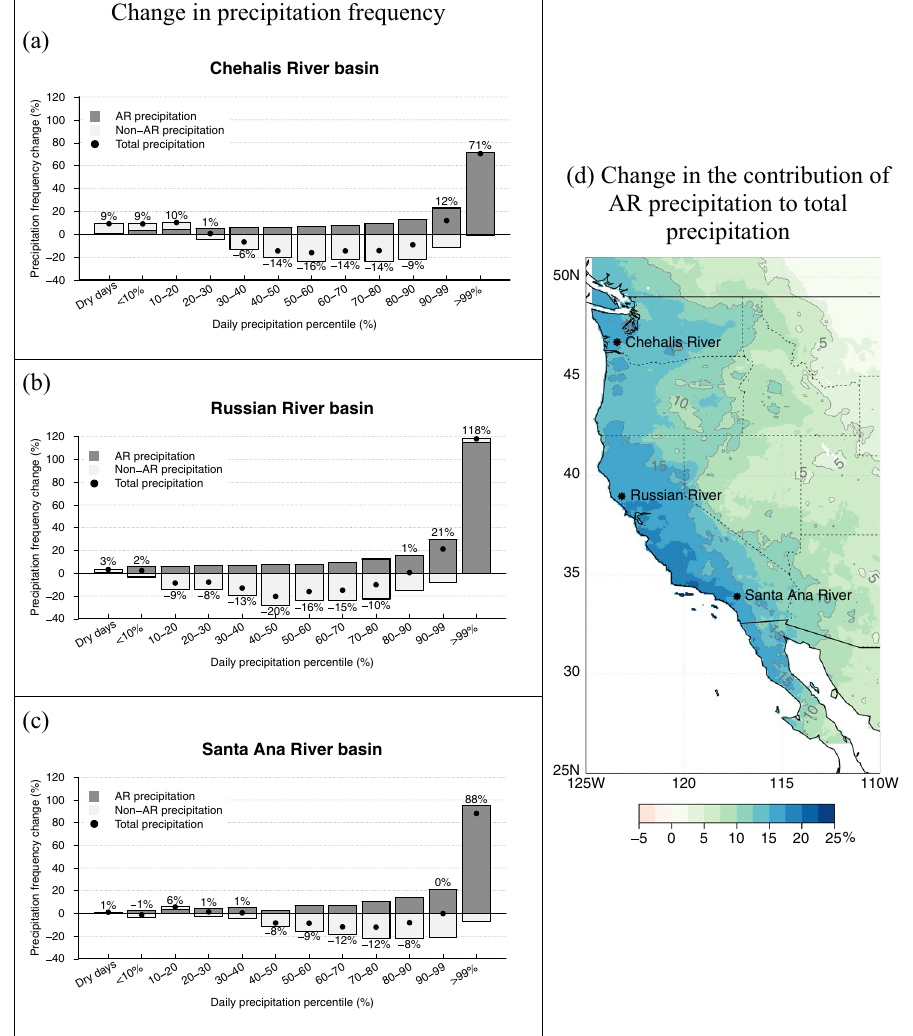
Figure 2. Future changes in daily precipitation frequency binned by percentile ranges of daily intensity (% of historical climatology). Results represent ensemble averages for the Real-5 LOCA-downscaled GCMs for the Chehalis, Russian and Santa Ana river basins ( a – c , respectively). Changes in total precipitation are denoted by dots and associated values; AR-related precipitation (for each AR day and the following day) – dark grey bars; and non-AR precipitation – light grey bars. Panel (d) illustrates Real-5 ensemble average change in the contribution of AR-related precipitation to total precipitation (in % of historical contribution see Fig.